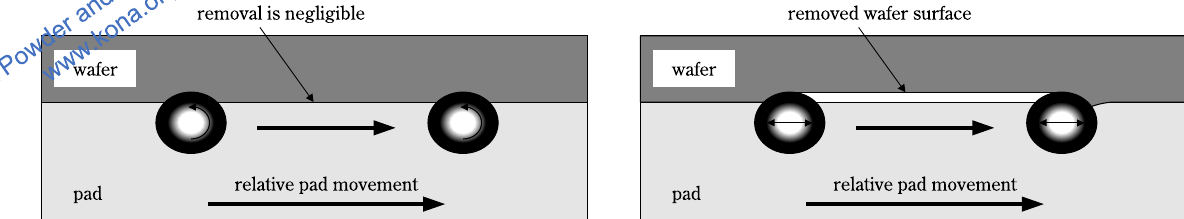
Fig. 2.1: Abrasive Rolling (on left); Abrasive Sliding (on right) (Reprinted from reference 16; Reproduced by permission of ECS ― The Electrochemical